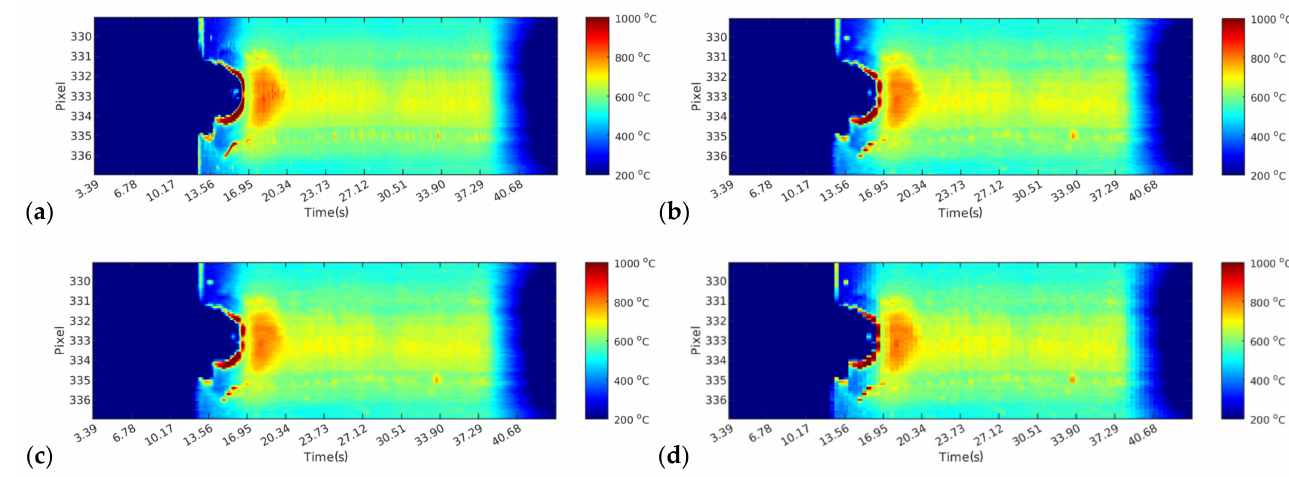
Figure 11. Results of emissivity and reflected temperature correction: ( a ) constant, uncorrected emissivity and reflected temperature; ( b ) constant corrected emissivity and uncorrected temperature; ( c ) constant corrected emissivity and corrected reflected temperature—correction map applied.